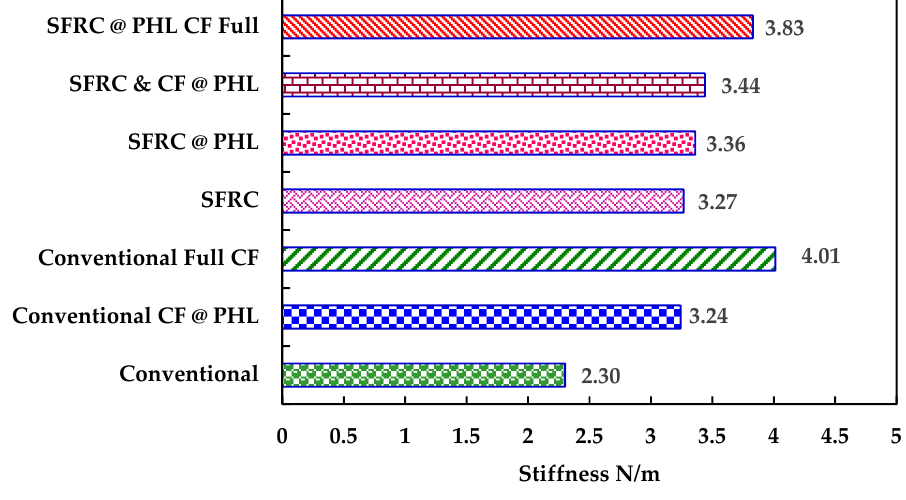
Figure 14. Stiffness of different RC beams.